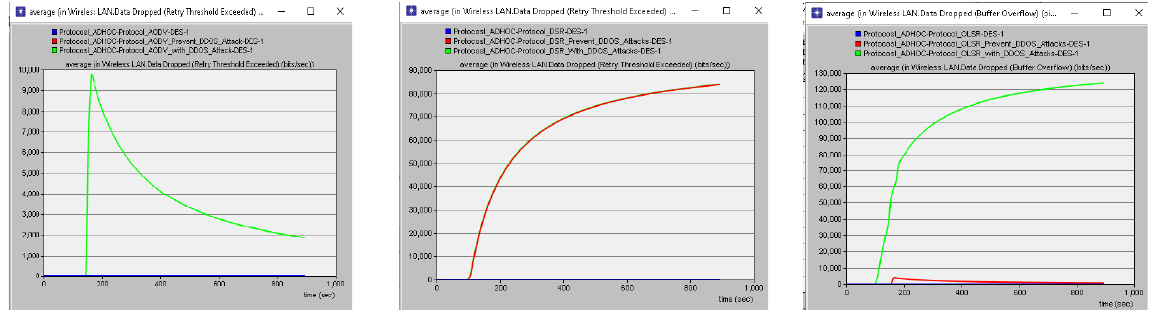
Fig. 3. Packet Loss/Drop Packet for each protocol in different scenario